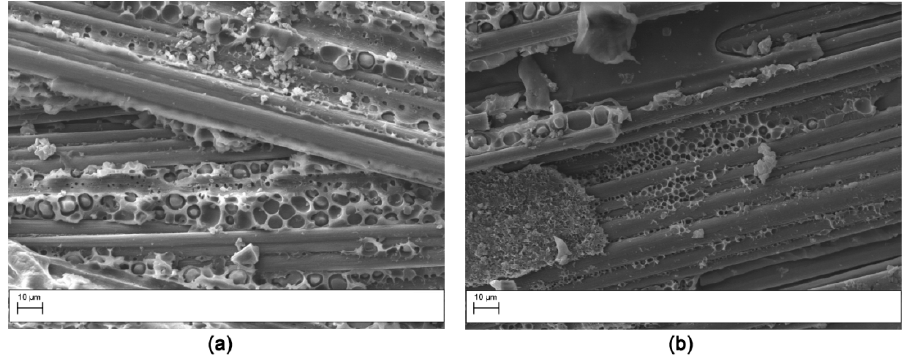
Figure 14. SEM of the fracture surface for the V1 modified DCB sample (Magnification 2000 × ). The analysis was carried out on the two halves resulting by specimen opening. ( a ) right side, ( b ) left side.